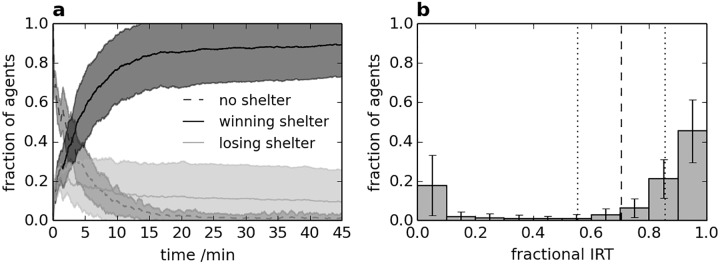
Aggregation dynamics and IRT distribution with fr = 0 (i.e. no personality differences).(a) Time-series of woodlice locations. Shaded areas show the standard error of the mean from 50 repetitions of the experiment. (b) Distribution of IRT values. Error bars show the standard error of the mean for each interval. The vertical dashed line shows the mean IRT and the dotted vertical lines show the standard error.